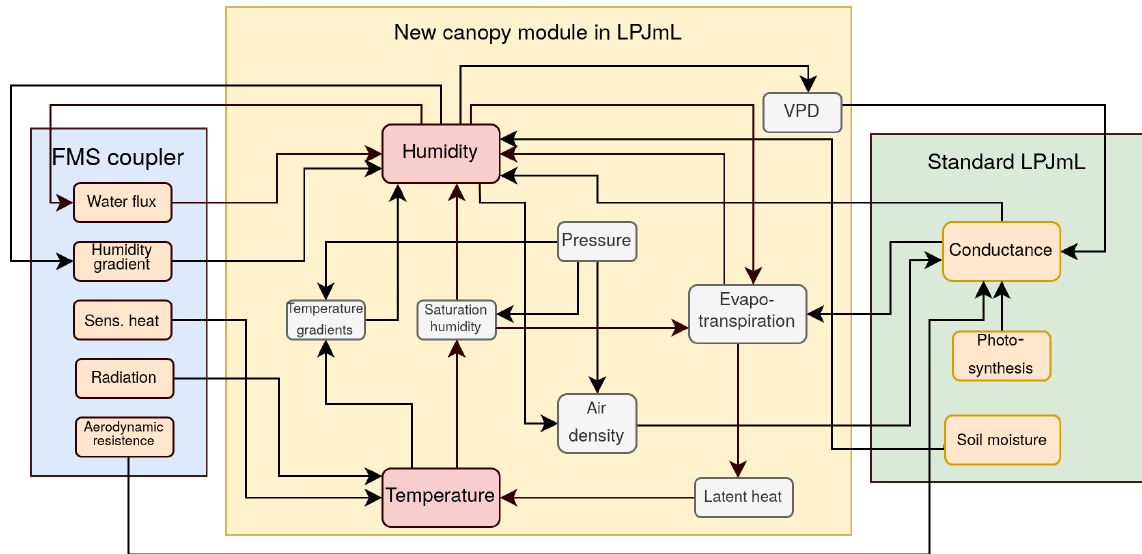
Figure 2. Schematic overview of the new canopy module.